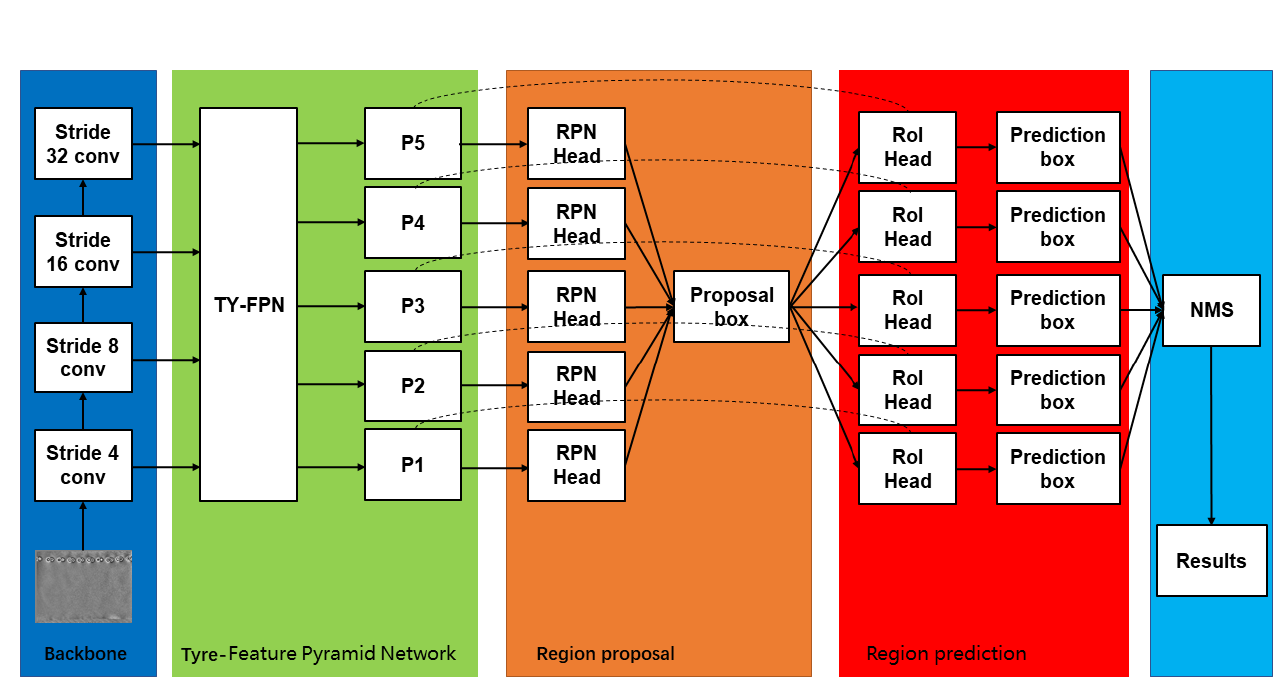
Figure 2. Improved bubble defect detection algorithm. It includes four parts: Backbone, Tyre-Feature Pyramid Network, Region proposal, and Region